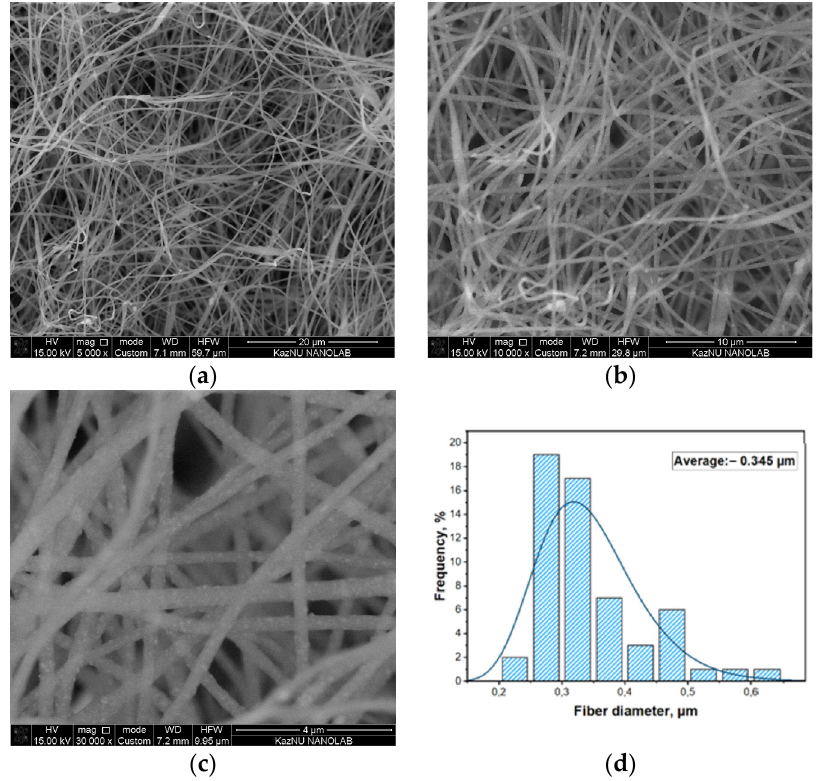
Figure 6. ( a – c ) SEM images of PAN/Fe 3 O 4 fibers at various magnifications; ( d ) distribution of PAN/Fe 3 O 4 fibers according to diameter.